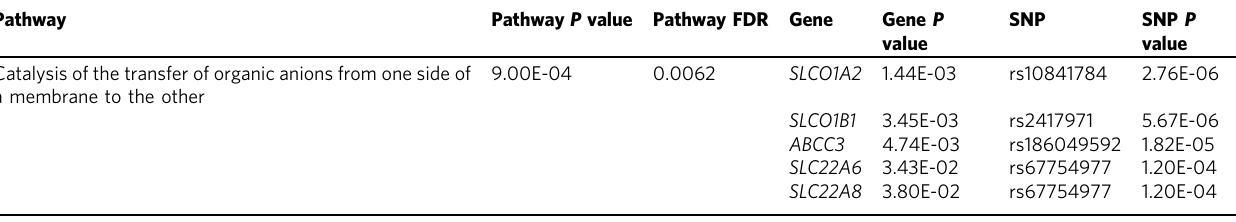
FDR false discovery rate, GWAS genome-wide association study, MAGENTA Meta-Analysis Gene-set Enrichment of variaNT Associations, SNP single-nucleotide polymorphism The most signi fi cant pathway (gene sets) with a gene set enrichment FDR < 0.01 are